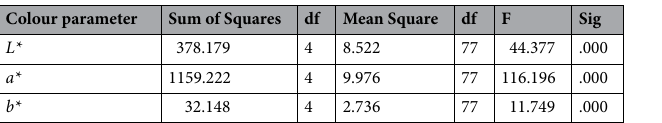
Table 2. Cluster variance analysis of beryl